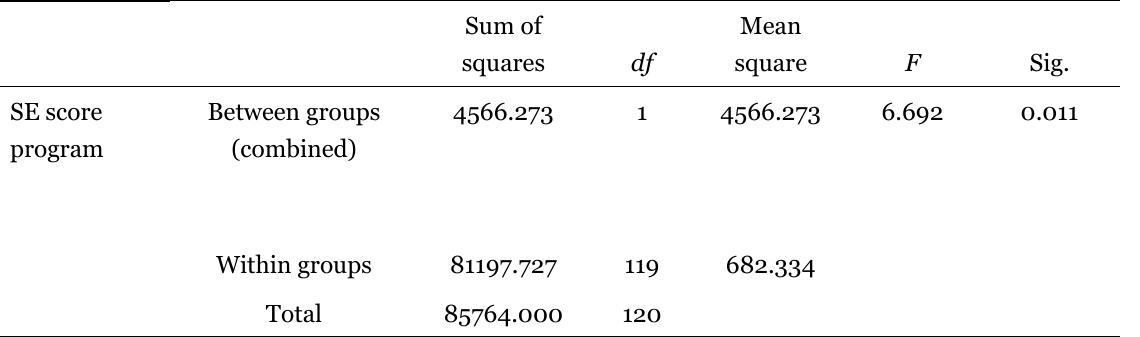
Self-Efficacy (SE) Scores by Program: ANOVA Results